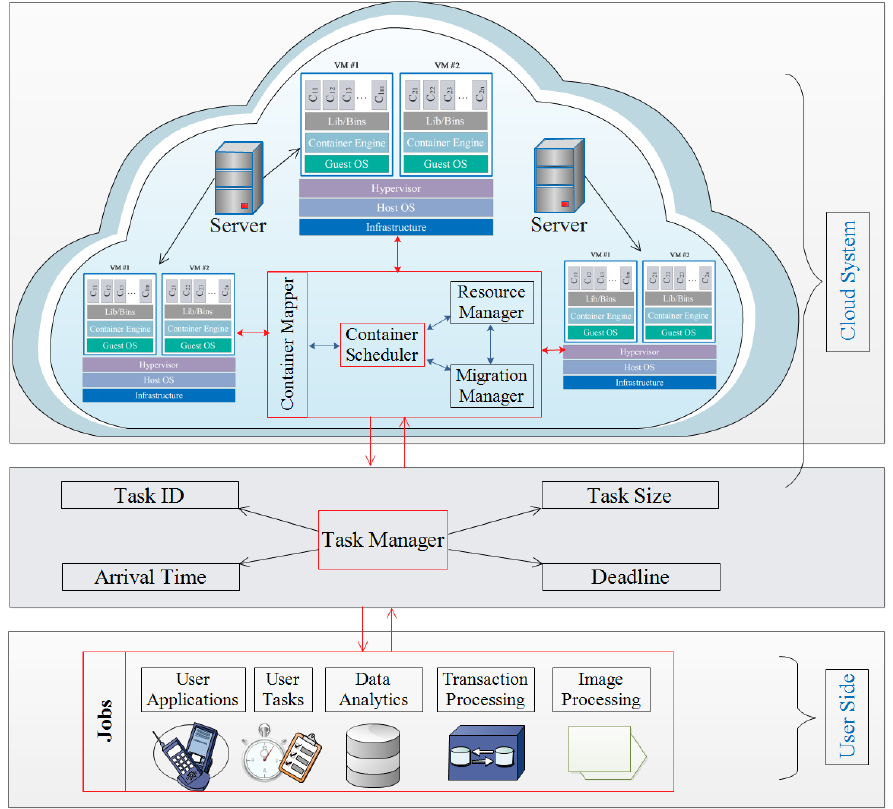
Figure 3. Architecture for CaaS